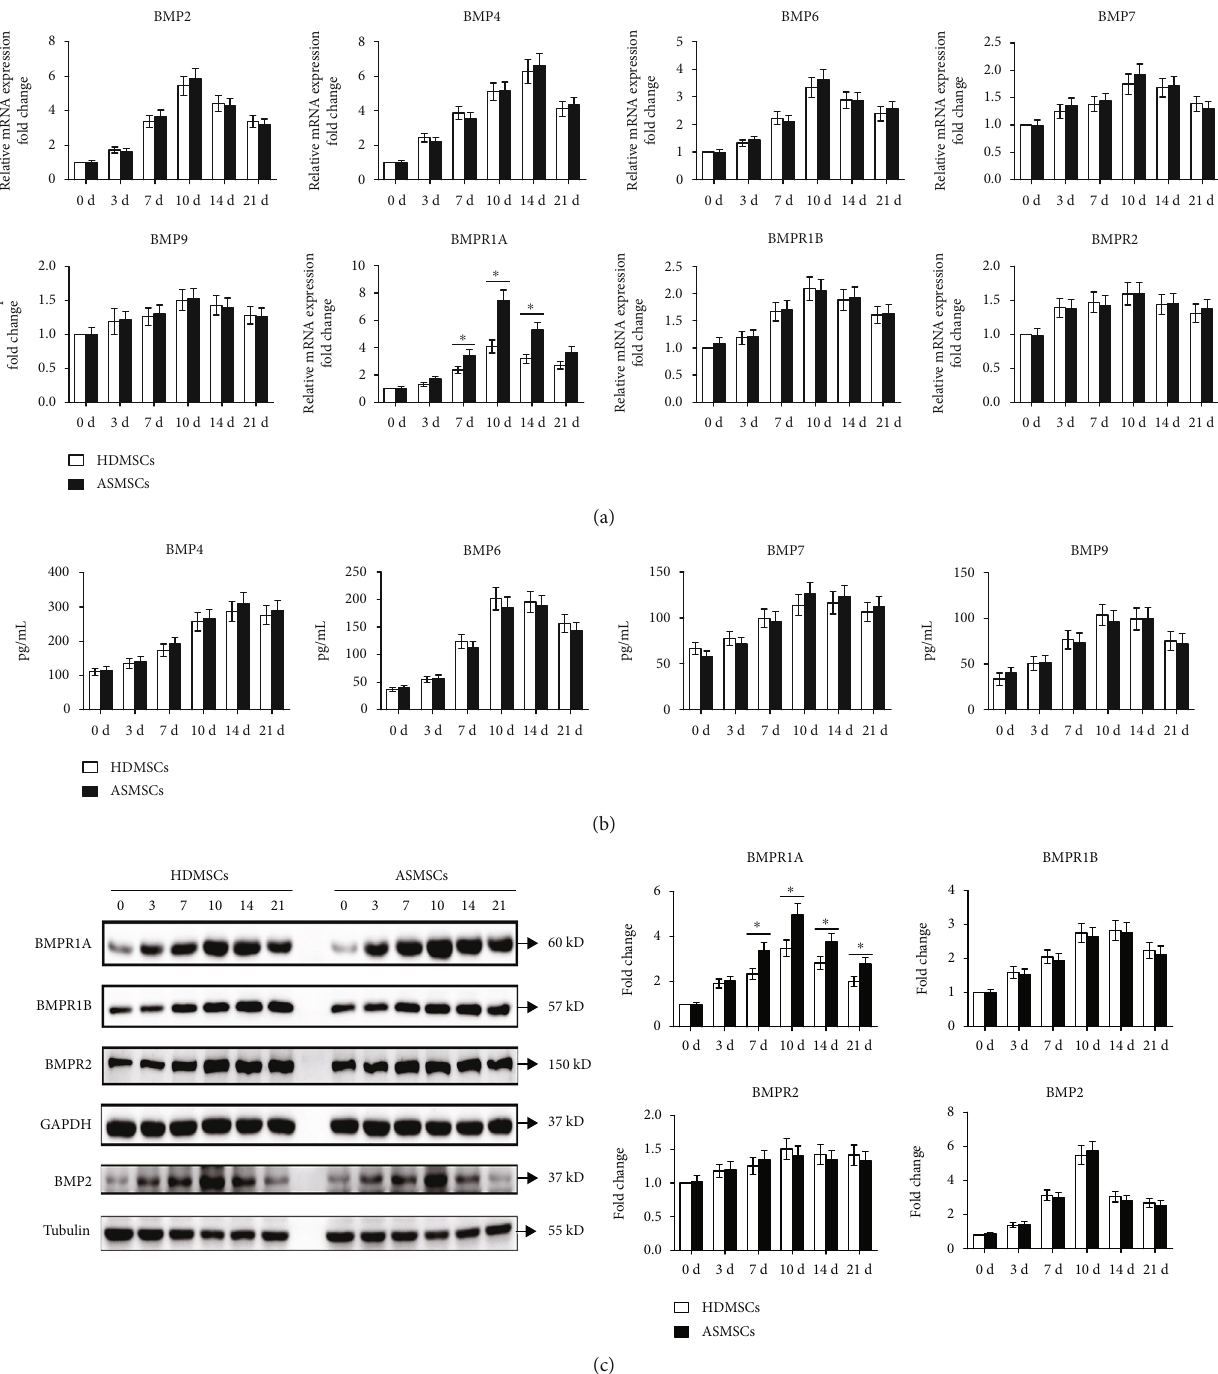
Figure 4: Higher BMPR1A expression was detected in ASMSCs than in HDMSCs during adipogenesis. (a) qRT-PCR was performed to detect the gene expression of BMP2, BMP4, BMP6, BMP7, BMP9, BMPR1A, BMPR1B, and BMPR2 during adipogenesis. ASMSCs ( n = 25 ) expressed BMPR1A at higher levels than HDMSCs ( n = 30 ) on days 7, 10, and 14. No signi fi cant di ff erence was found between HDMSCs and ASMSCs with regard to the mRNA expression of BMP2, BMP4, BMP6, BMP7, BMP9, BMPR1B, or BMPR2. (b) ELISA was used to detect the protein expression of BMP4, BMP6, BMP7, and BMP9. The results were consistent with those of mRNA expression. (c) The protein expression of BMPR1A, BMPR1B, BMPR2, and BMP2 was determined by Western blotting. ASMSCs ( n = 25 ) had higher BMPR1A protein expression than HDMSCs ( n = 30 ) during adipogenic di ff erentiation, whereas the protein expression levels of BMPR1B, BMPR2, and BMP2 were comparable between HDMSCs and ASMSCs. Values are presented as the means ± SDs . ∗ P < 0 : 05 for the di ff erences between HDMSCs and